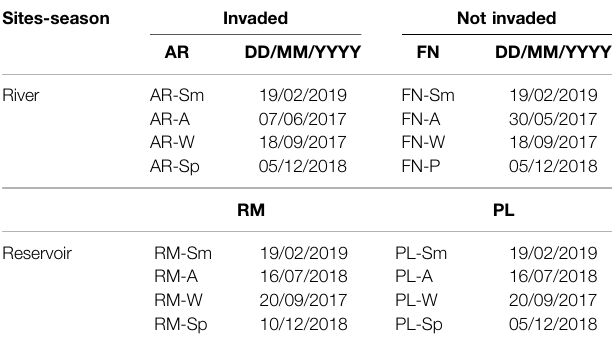
TABLE 1 | Sampling labels acording to site and date, with three replicates each one. River (AR, Arroyito; FN, Fortín Nogueira) and reservoir (RM, Ezequiel Ramos Mexía; PL, Pichi Picún Leufú) sites of Limay River, Patagonia. Sm, summer; A, autumn; W, winter and Sp,